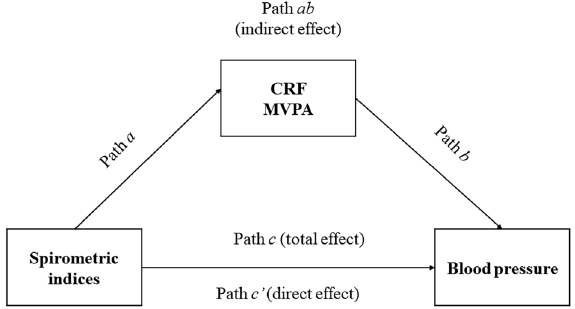
Figure 2. The structural equation modeling used in the present study for assessing the mediation role of cardiorespiratory fi tness (CRF) and moderate-to-vigorous physical activity (MVPA) in the correlation between lung function and blood